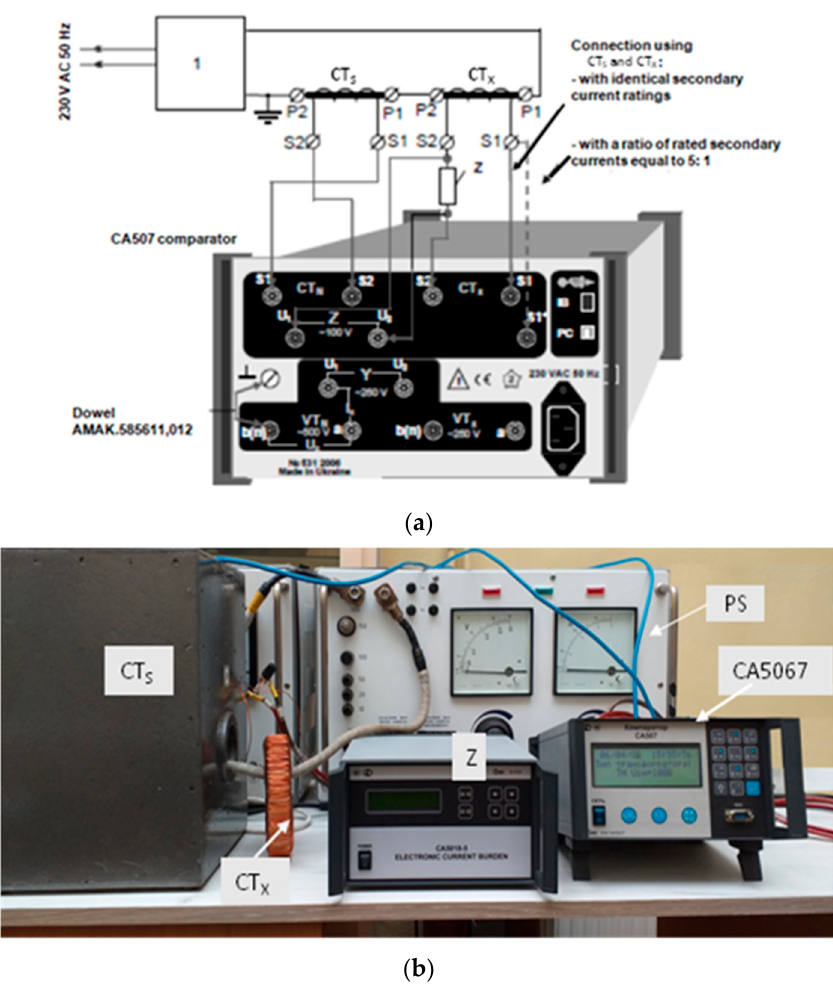
Figure 5. ( a ) Diagram and ( b ) picture of the system for measuring transformation errors of current transformers: CA507 = comparator; PS = power supply system—current source, consisting of a voltage regulator and a transformer; CT S = reference current transformer; CT X = tested current transformer; Z = impedance—secondary winding burden of the tested transformer. Table 2. The accuracy data of the CA507 comparator based on the user manual. The characteristics of the current error and phase displacement error, obtained from the calculations and measurements of the 600 A/5 A current transformer with a toroidal